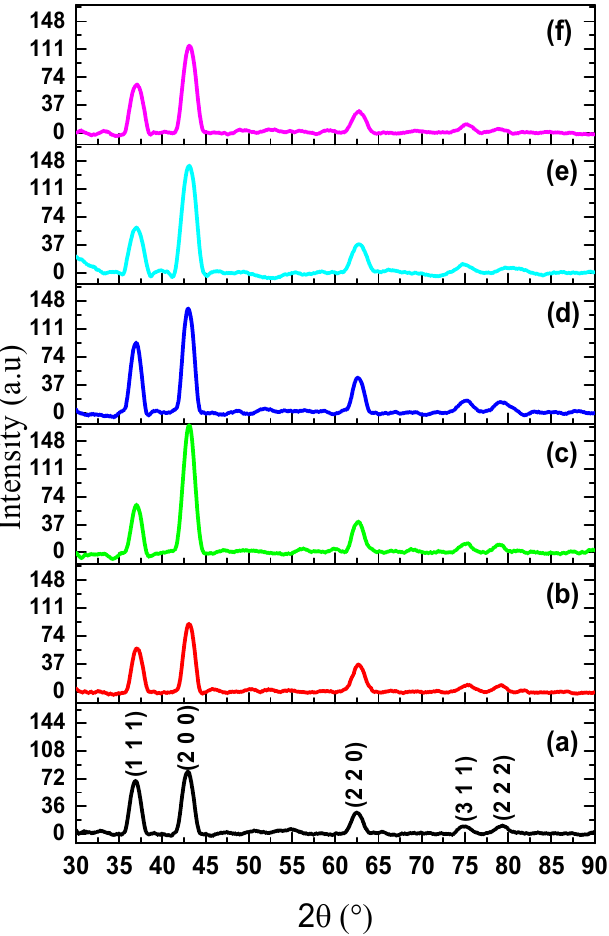
Figure 1. XRD patterns of pure and Cu-doped NiO films. ( a ) Pure NiO, ( b ) 2% Cu-doped NiO, ( c ) 4% Cu-doped NiO, ( d ) 6% Cu-doped NiO, ( e ) 8% Cu-doped NiO, and ( f ) 10% Cu-doped NiO.